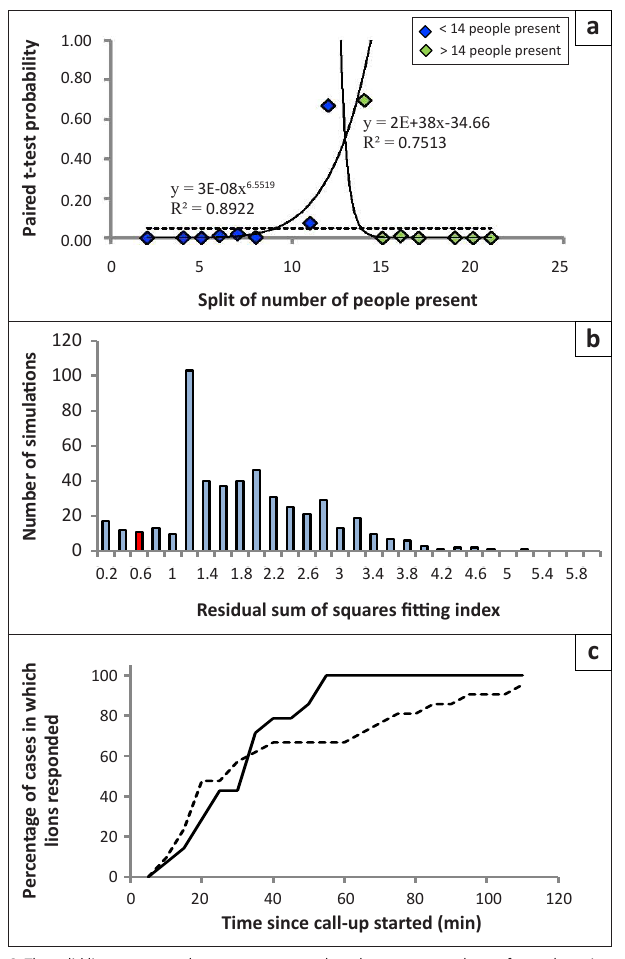
C, The solid line represent the response curve when there were equal to or fewer than nine people at the capture site. The broken line is the paired response curve when there were more than nine people at a capture site. FIGURE 3: The responses of lions in relation to the number of people present at a call-up site during lion captures in the Kruger National Park in 2010 . Paired t -tests between a response curve for fewer than a specified number of people and the paired response curve for more people than the same specified number of people (people split) (a); Simulation results illustrating the residual sum of squares fitting index (Red column) of the observed relationships between the probabilities of paired t -tests and people split in relation to the distribution derived from 500 simulations of random responses (b); Response curves at the optimised people split (9)